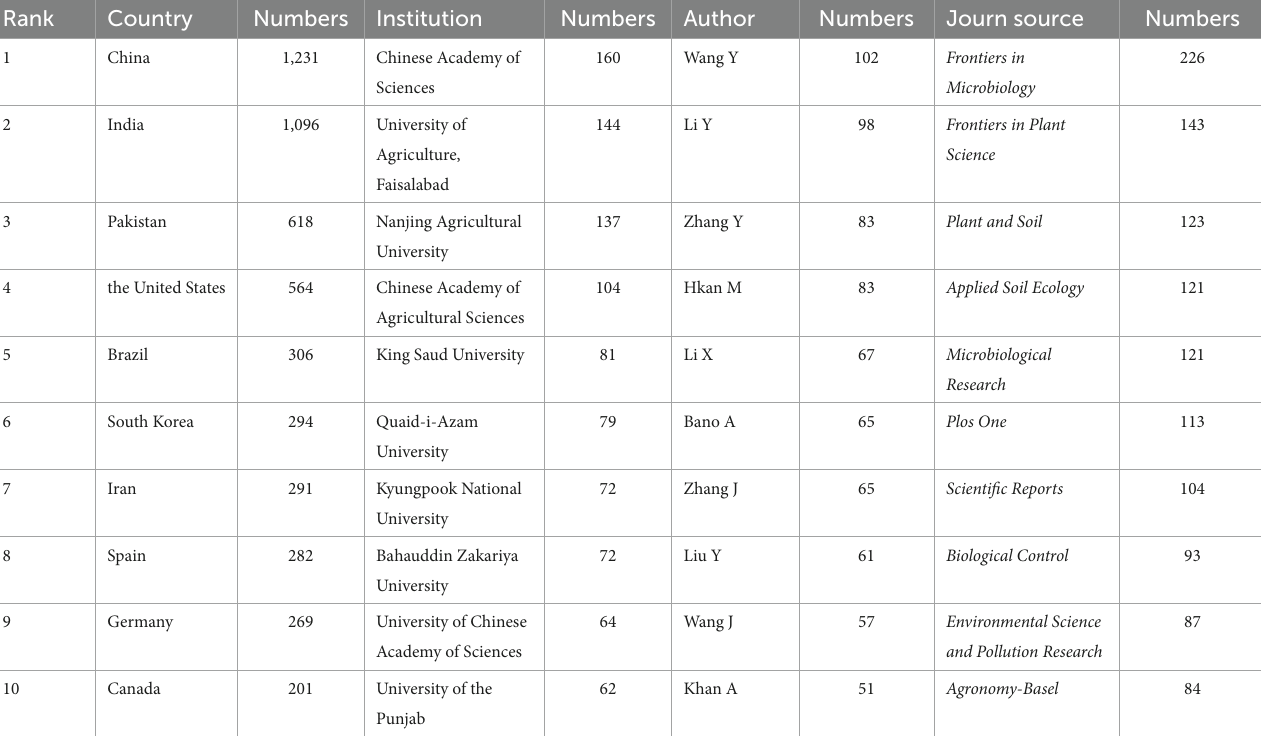
TABLE 1 The 10 countries/regions, institutions, authors, and journals with the most rhizosphere microorganism publications from 2012 to 2021. Rank